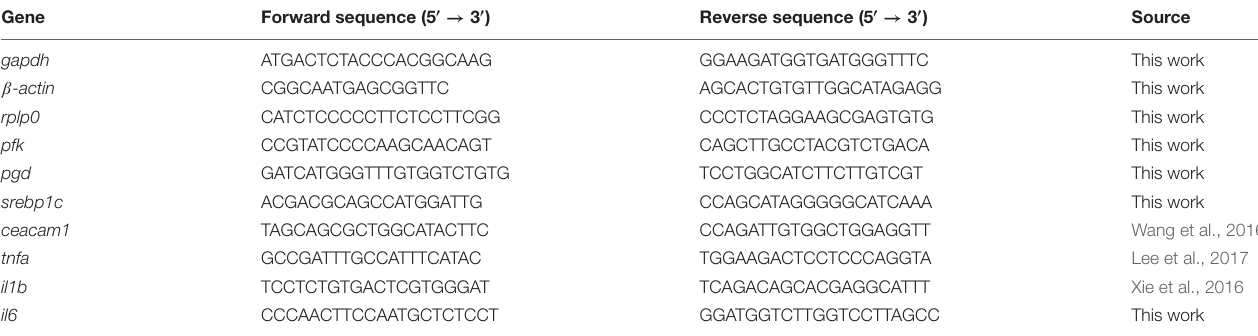
TABLE 1 | Primers utilized in qRT-PCR experiments. Gene Forward sequence (5 (cid:48) → 3 (cid:48)